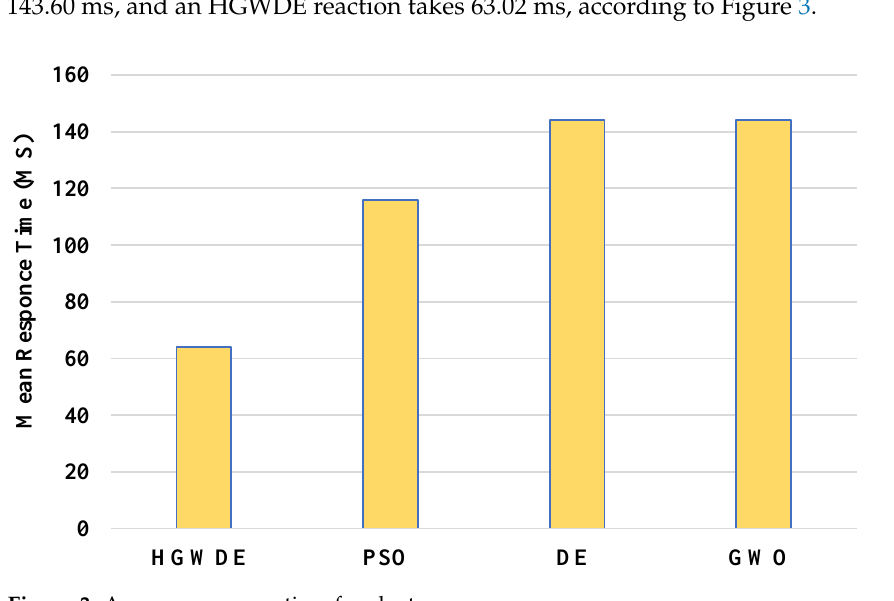
Figure 3. Average response time for clusters.